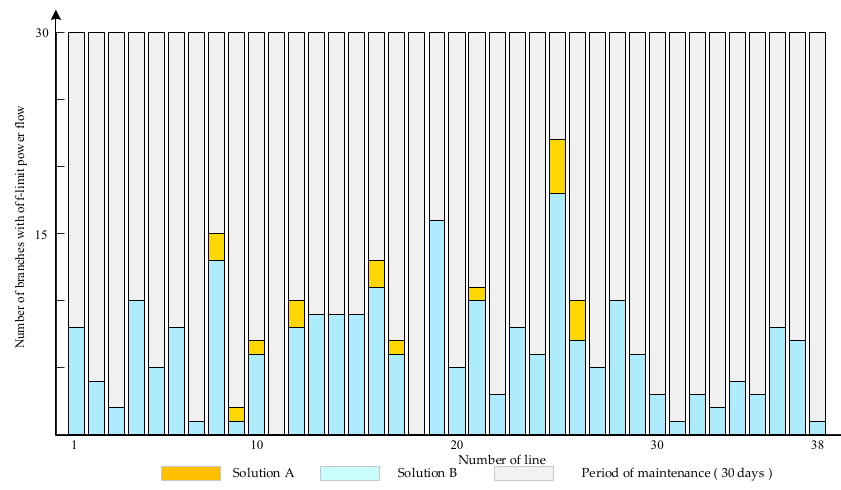
Figure 8. System power flow off-limit during maintenance period.